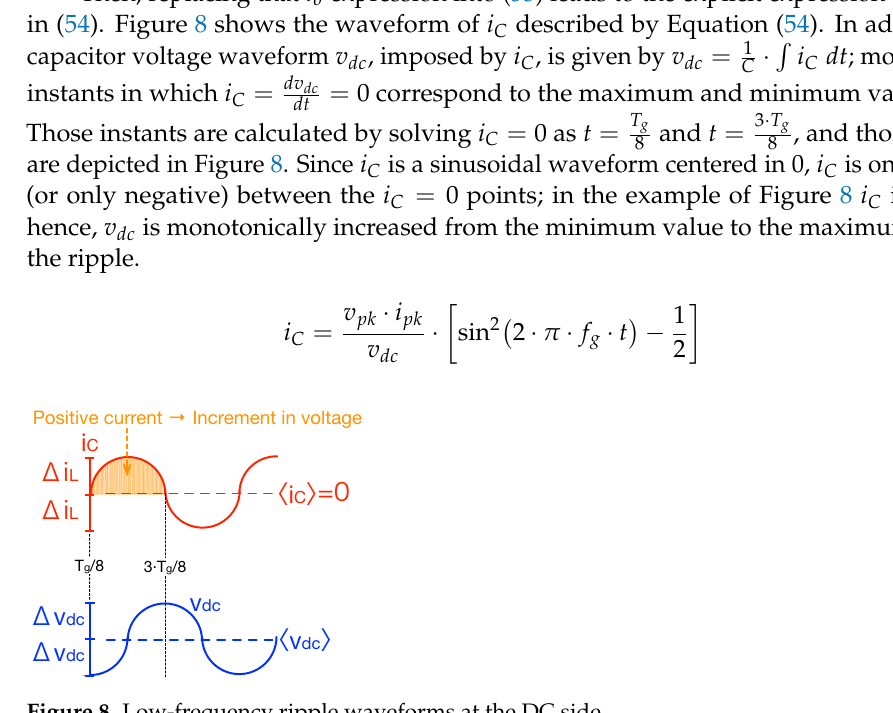
Figure 8. Low-frequency ripple waveforms at the DC